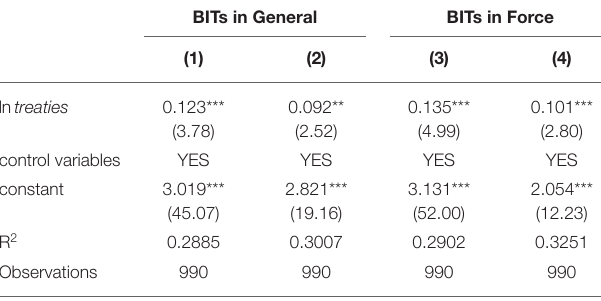
TABLE 5 | Robustness test II.